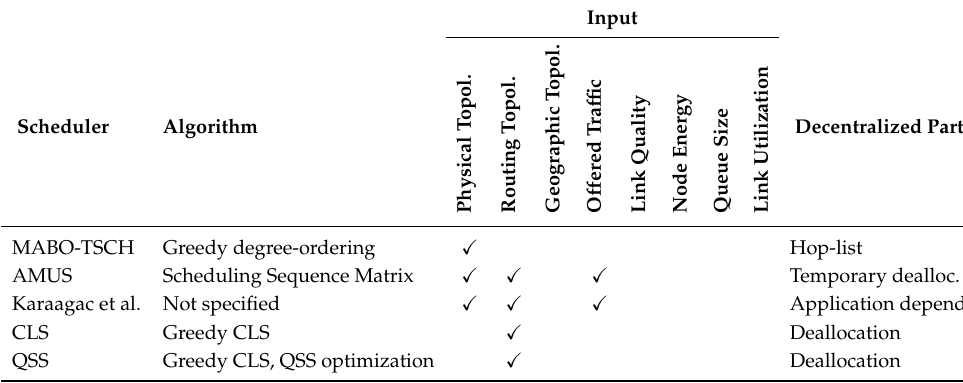
Table 11. Components of centralized-based hybrid TSCH